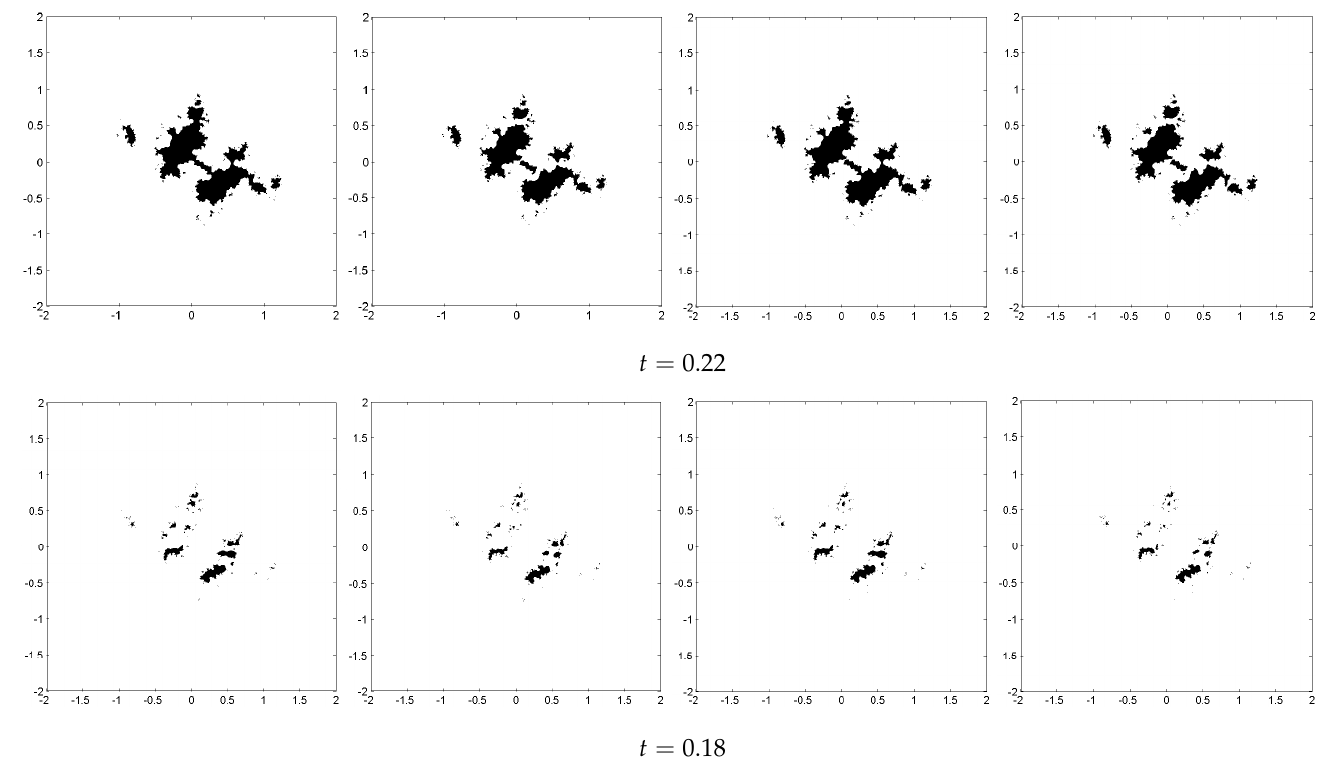
Figure 5. Consensus of Julia sets without leader and v = − 0.2 and different values of t in (11).